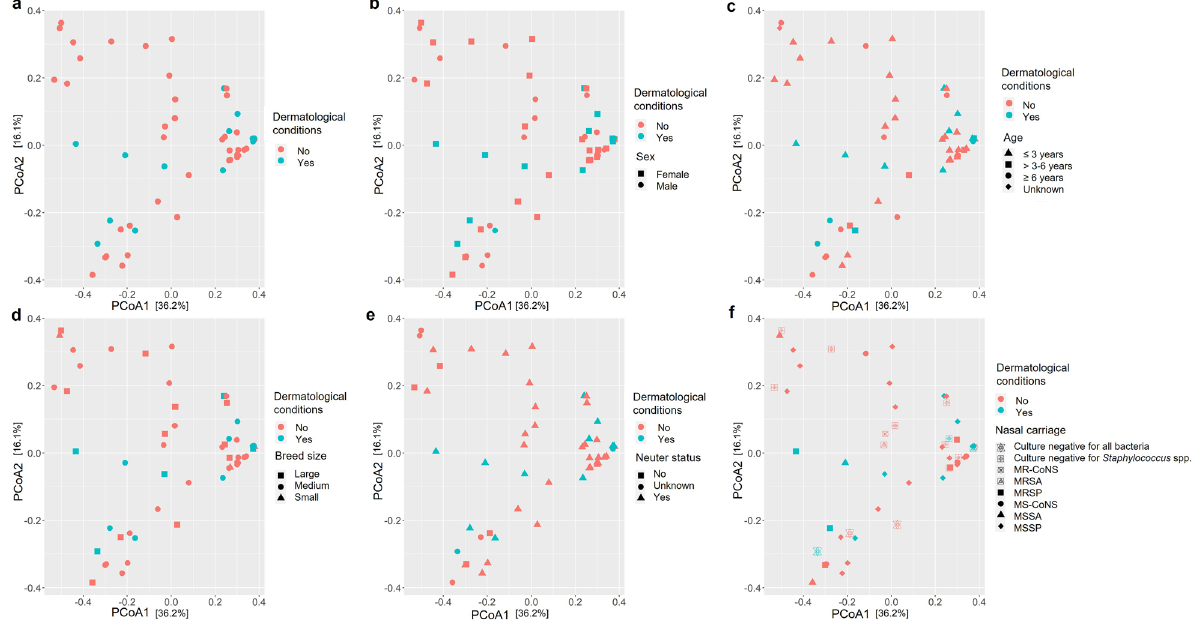
Figure 2. PCoA plots with Bray–Curtis displaying the amplicon sequence variants (ASVs) from the nasal samples (n = 52) from (a) dogs with (yes) and without (no) dermatological conditions and comparing that to (b) sex; (c) age; (d) breed size; (e) neuter status; and (f) nasal carriage represented by the corresponding symbols per